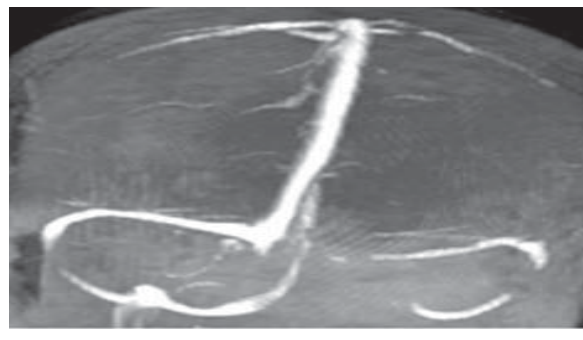
Figure 6. MRV showing occipital sinus Table 1. Visualization of the intracranial veins Paired structures